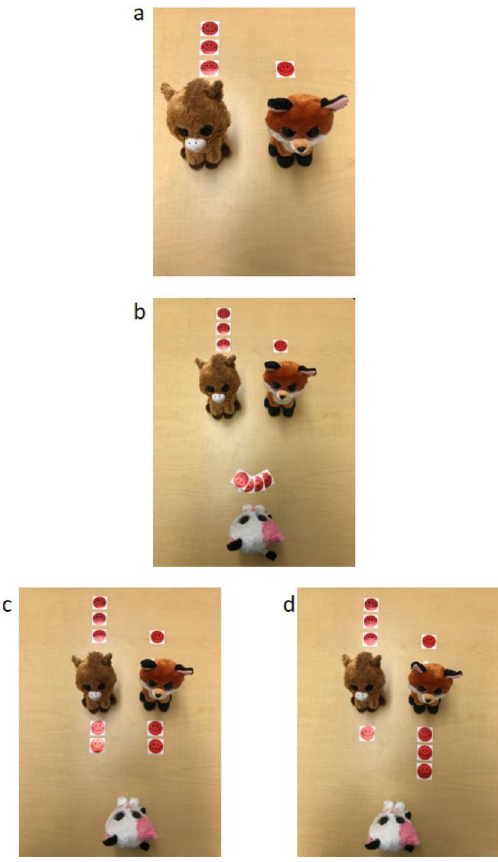
Figure 1. ( a – d ) Pictures used throughout the studies. Children were introduced to two characters (Pony and Foxy) with different resources ( a ), then a character (Kitty) who would give more resources to Pony and Foxy ( b ). Children were asked which distribution Kitty should make – one where both recipients get the same number, but where the inequity is preserved ( c ) or one where the recipients get different numbers, but where the final outcome is equitably ( d ). See methods for